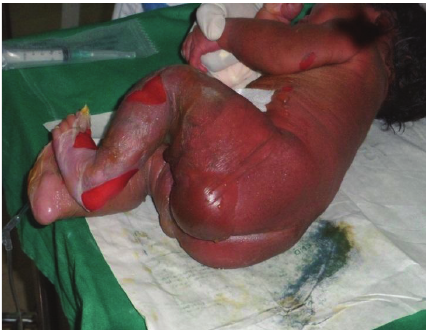
Figure 1: Staphylococcal Scalded Skin Syndrome in a newborn with generalized bullous epidermolysis.